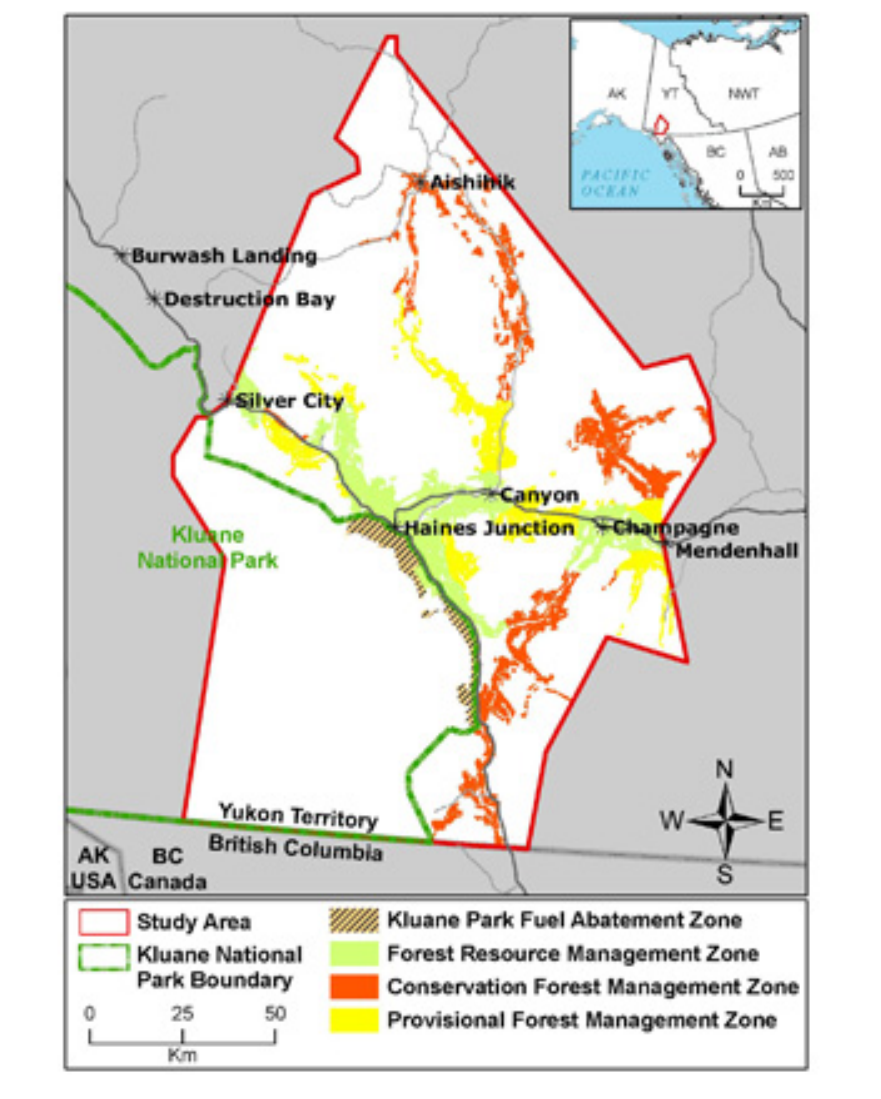
Fig. 1. Study area—the Champagne and Aishihik First Nations Traditional Territory in southwest Yukon, Canada (Source: Government of